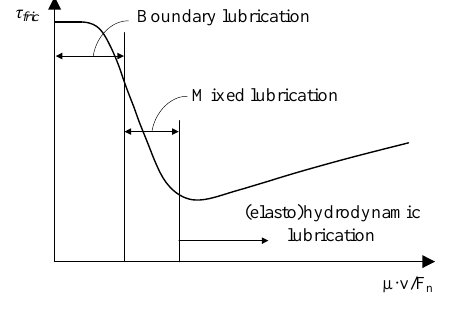
Figure 6: Stribeck diagram with lubrication regimes